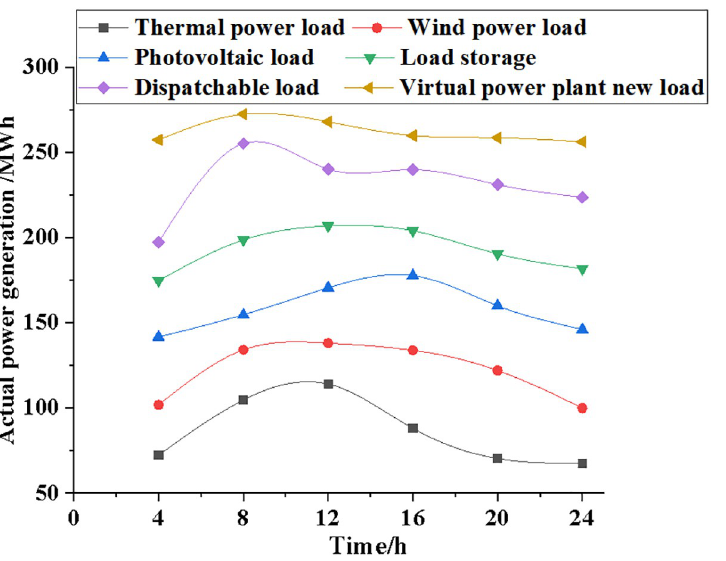
Fig 10. Change trend of actual power generation data of different power load types.